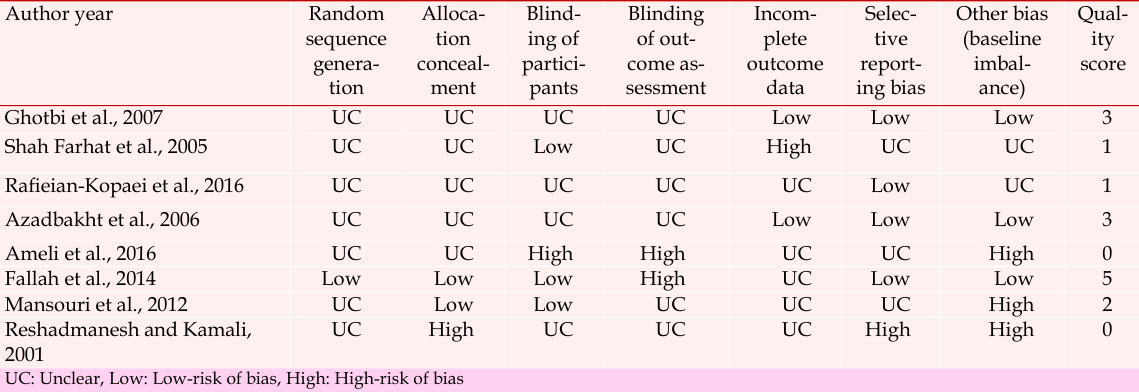
Methodological quality of included primary studies in according to cochrane risk of bias assessment tool Author year